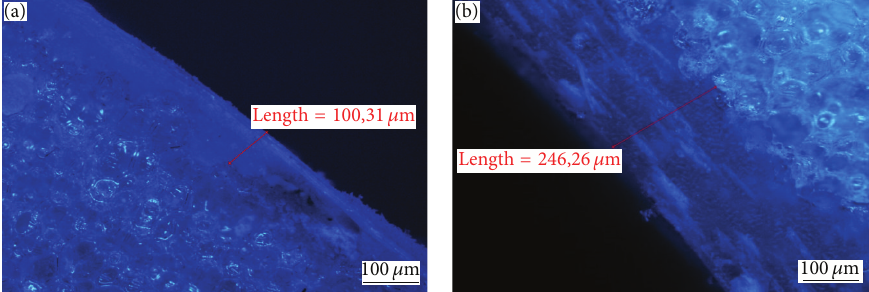
Figure 2: A comparison of thickness of outer structural skins in composites produced by means of contact reinforcement method with (a) STR 015-200-110 fabric and (b) EM 1004/300/125 mat.